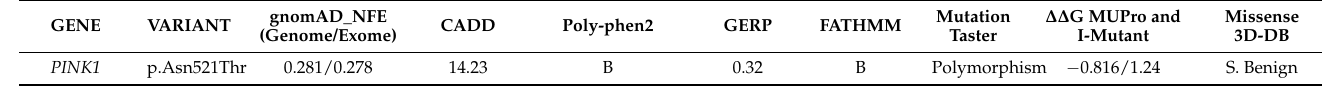
Table 5. PINK1 missense